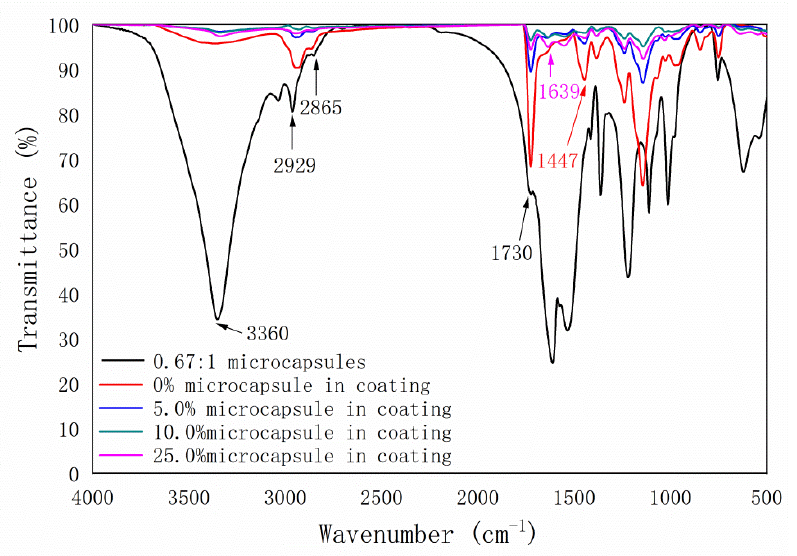
Figure 7. IR spectra of the waterborne primer coating with different mass fractions of microcapsules (the core–shell ratio is 0.67:1).